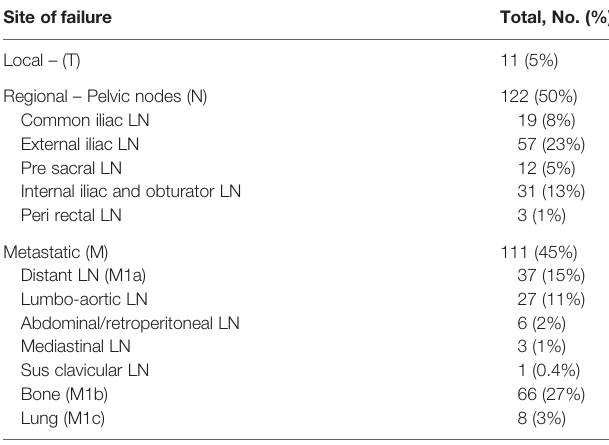
TABLE 2 | Total distribution of the 244 clinically detectable sites of